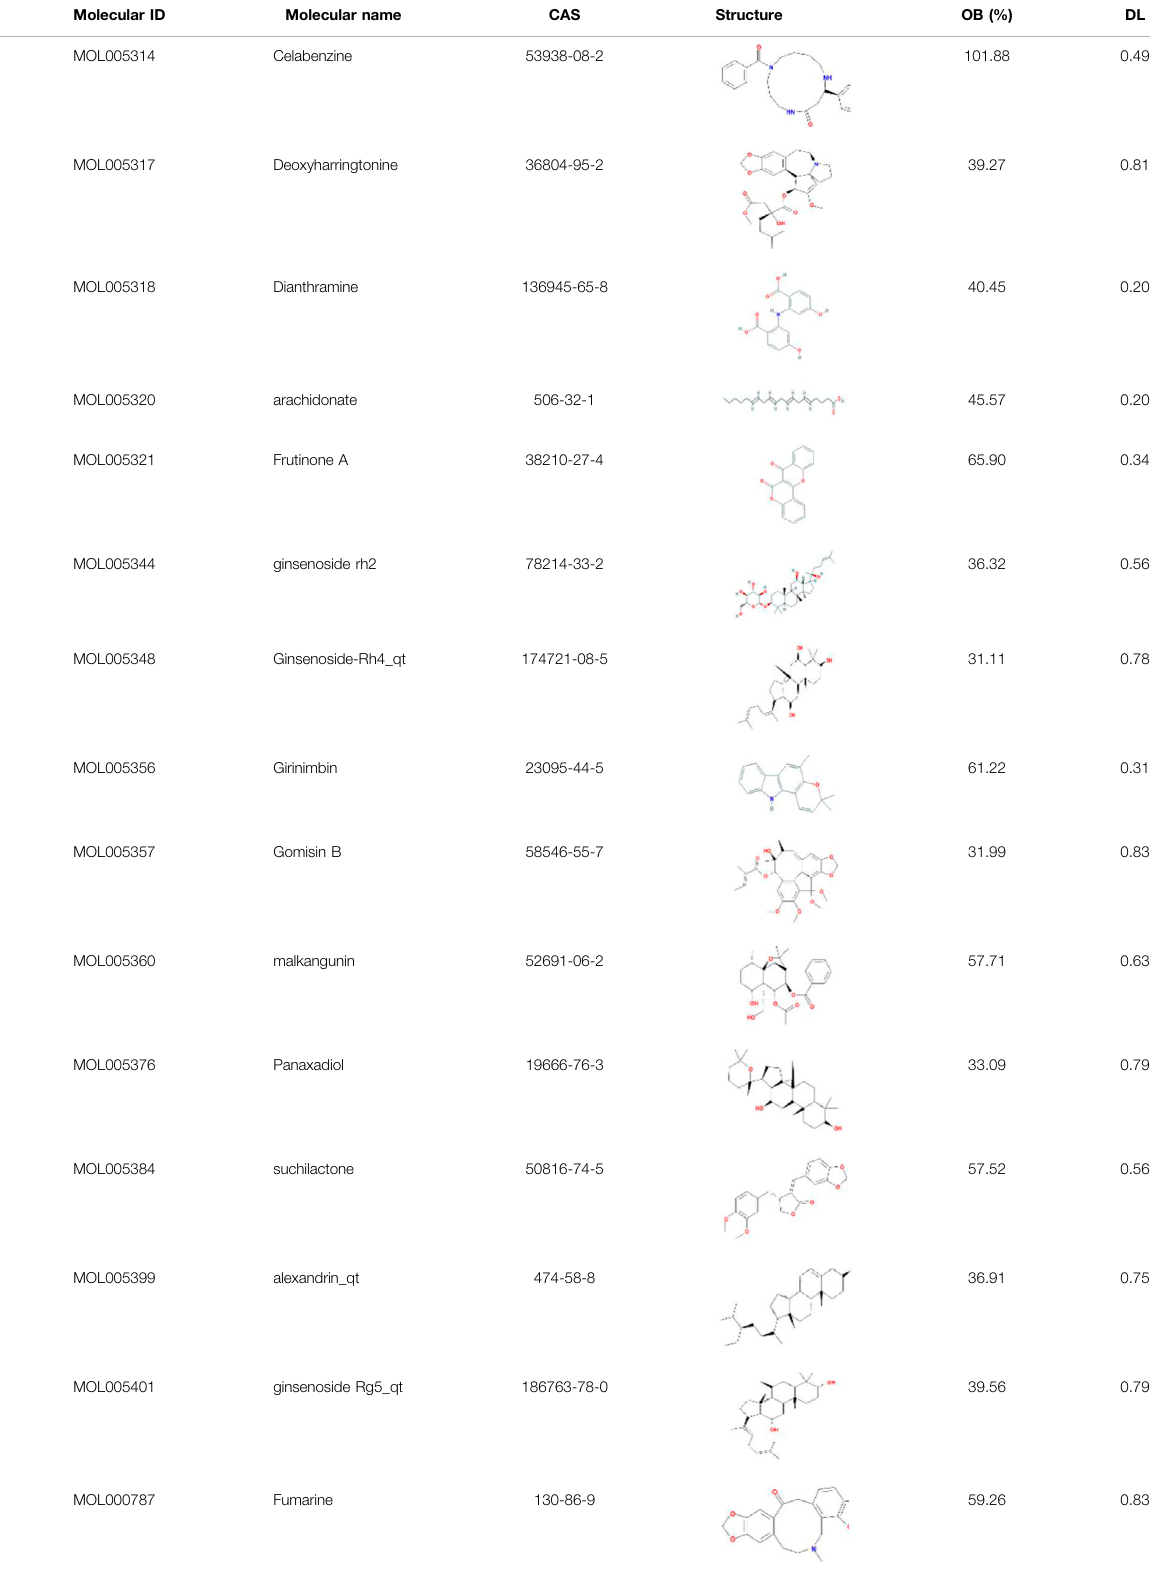
TABLE 1 | ( Continued ) The fi nal selected ingredients in YZQX for